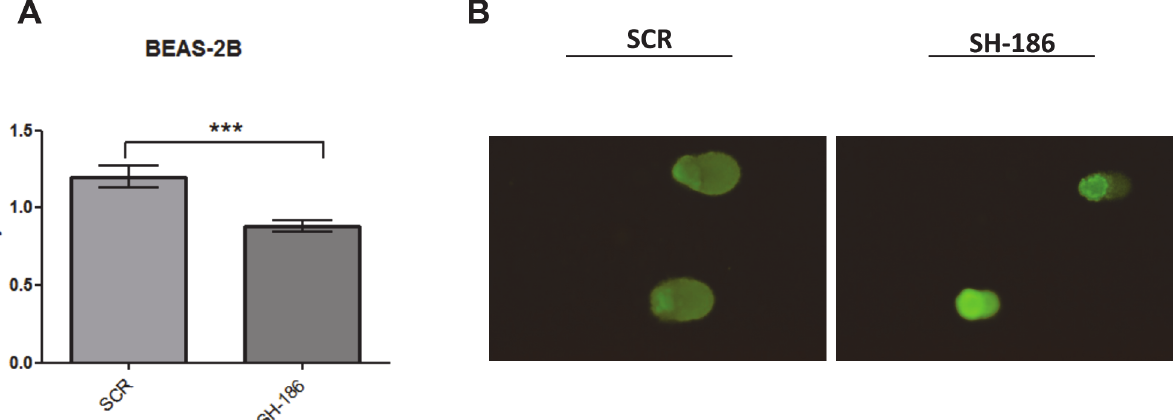
Fig 4. Lentiviral transduction of BEAS-2B cells with an shRNA for HPV-16 E6/E7 silencing reduces the DNA damage induced by CSC exposition. (A) BEAS-2B cells were exposed to 10 μ g/mL CSC and incubated with scrambled or shRNA SH-186. The DNA damage was evaluated using comet assay and the total area in each comet was measured. (B) A representative image showing BEAS-2B cells after incubation with SCR or shRNA SH-186.